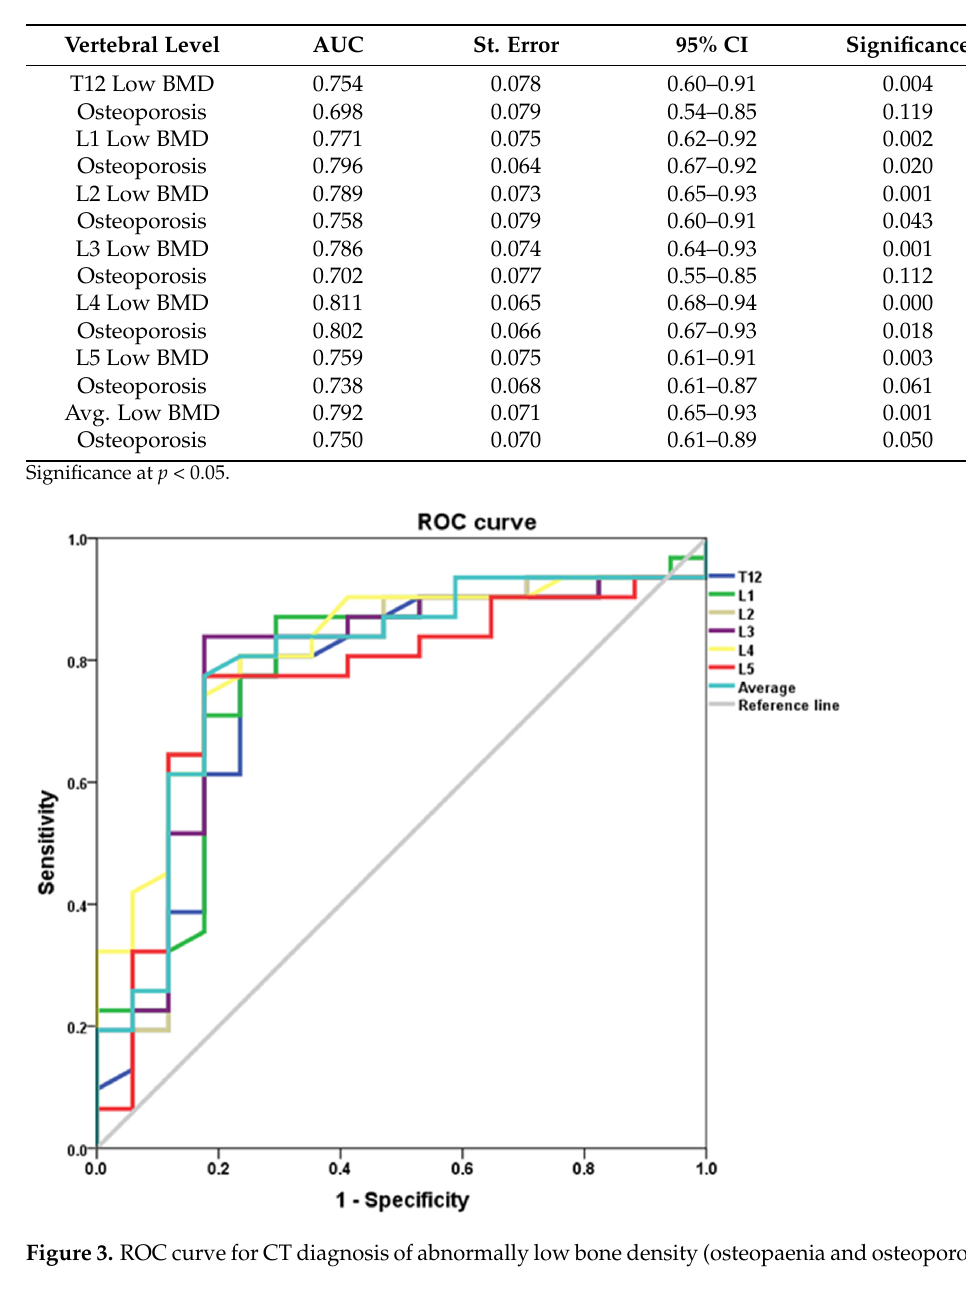
Table 3. Areas under the curve for diagnosis of low and osteoporotic bone mineral density by CT attenuation at each vertebral level.